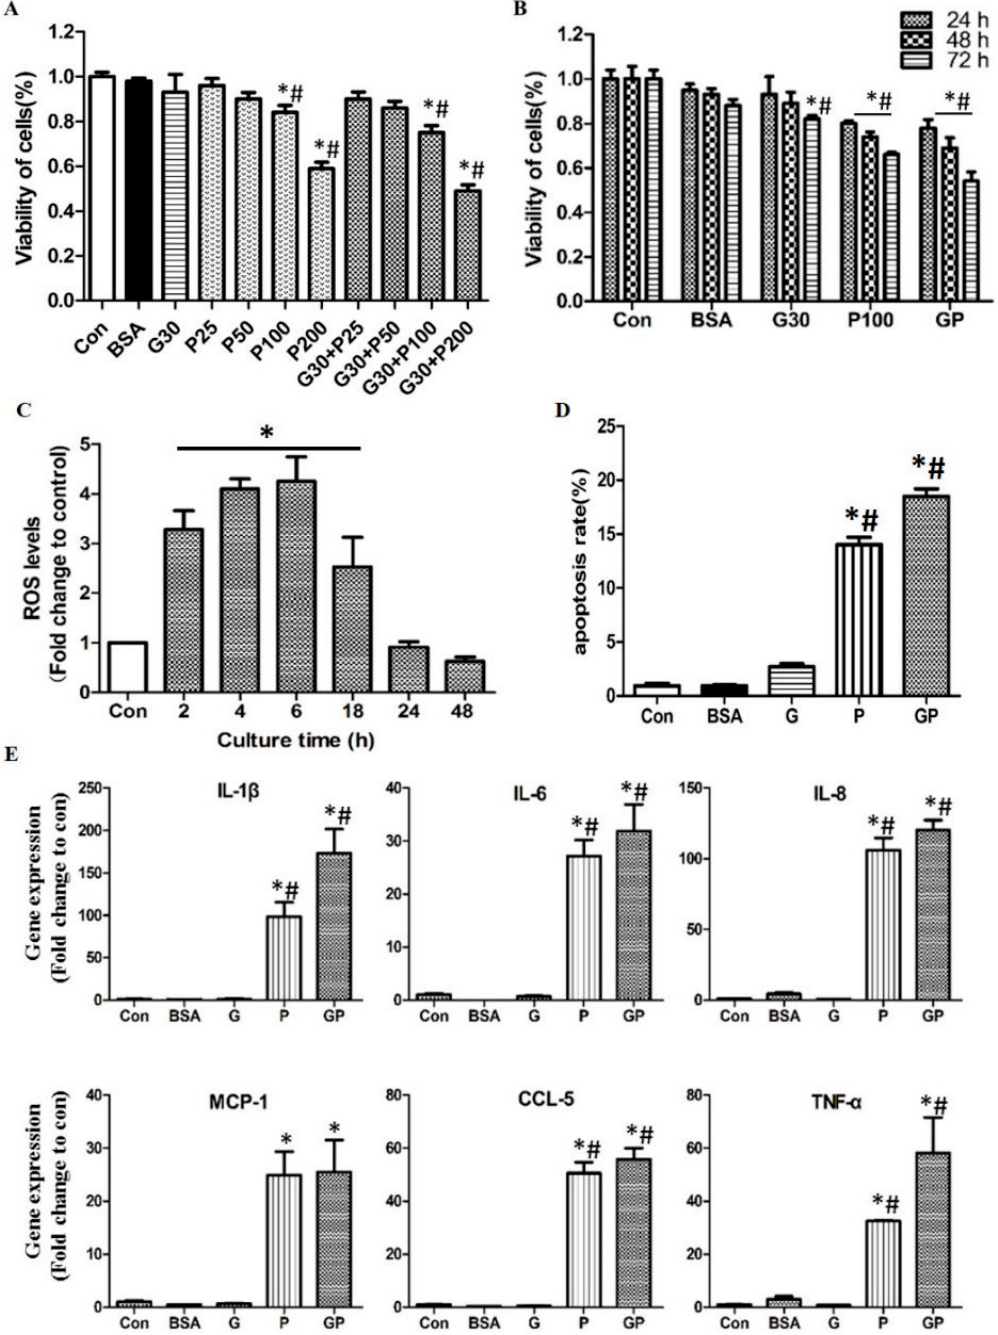
Figure 1. The effects of high glucose and palmitic acid on cell viability, reactive oxygen species (ROS) production, cell apoptosis and inflammation in human umbilical vein endothelial cells (HUVECs). ( A ) Dose dependent impairment of cell viability by 24 h palmitic acid (P) and glucose (G) treatments; ( B ) Time dependent impairment of cell viability by 24–72 h treatments of G or/and P. Cell viability was determined by CCK-8 kit; ( C ) ROS levels after GP treatment for 2–48 h were measured via flow cytometry; ( D ) Cell apoptosis was determined by Annexin-V and PI staining via flow cytometry in 48 h, and Annexin-V and PI double positive staining was calculated as late cell apoptosis rate. All the above data were presented as the percentage of control value; and ( E ) Relative gene expression of inflammation factors such as, IL-1 β , IL-6, IL-8, monocyte chemoattractant protein-1 (MCP-1), CC chemokine ligands 5 (CCL-5), and TNF- α by RT-qPCR in 24 h. Gene expression was normalized by β -Actin. Data were present as the mean ± SD for three independent experiments. G, glucose; P, palmitic acid; BSA, bovine serum albumin, as vehicle control; and GP, 30 mM glucose plus 100 μ M palmitic acid. * p < 0.05 GP, G or P versus control, # p < 0.05 G or P versus GP.